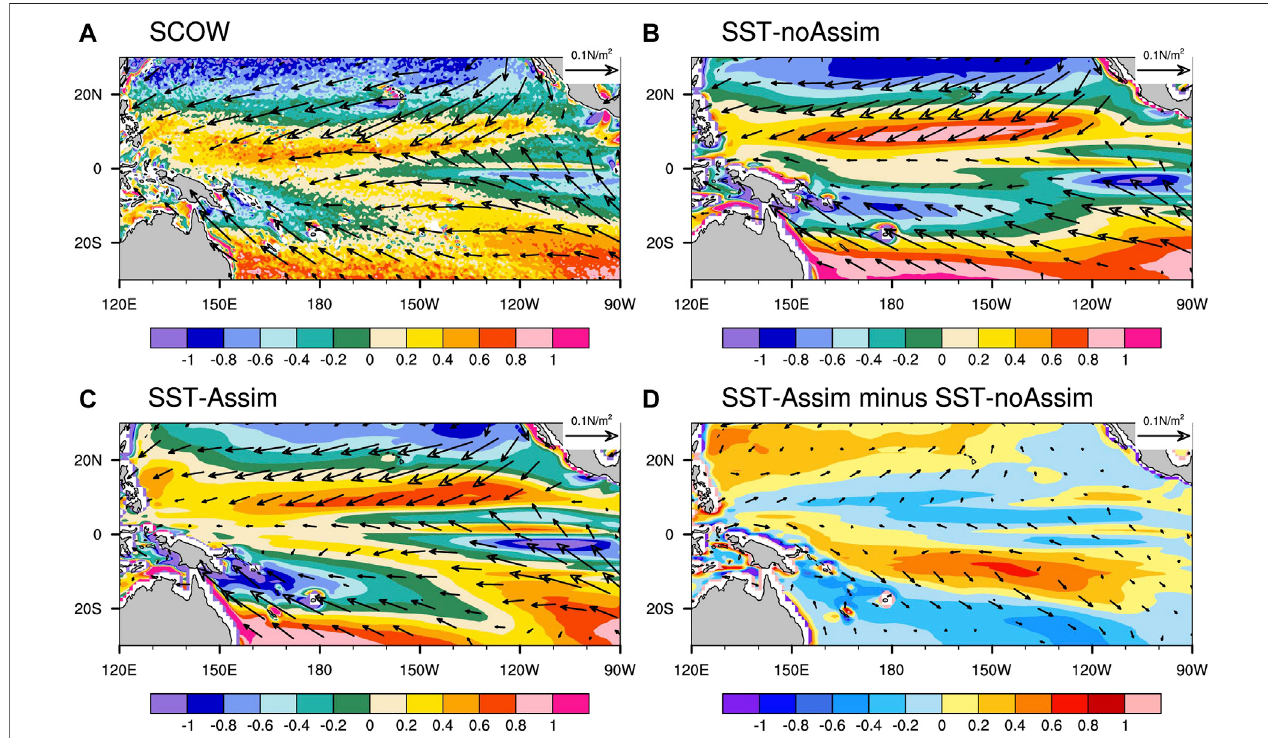
FIGURE 6 | Annual mean wind stress curl (WSC, shaded, in *10 – 7 N/m 3 ) and wind stress vector (arrows, in N/m 2 ) from (A) SCOW, (B) SST-noAssim experiment, (C) SST-Assimexperimentand (D) thedifferencebetweenSST-AssimexperimentandSST-noAssimexperiment(SST-Assim minusSST-noAssim).Theaverageperiod of the model data is from 1982 to